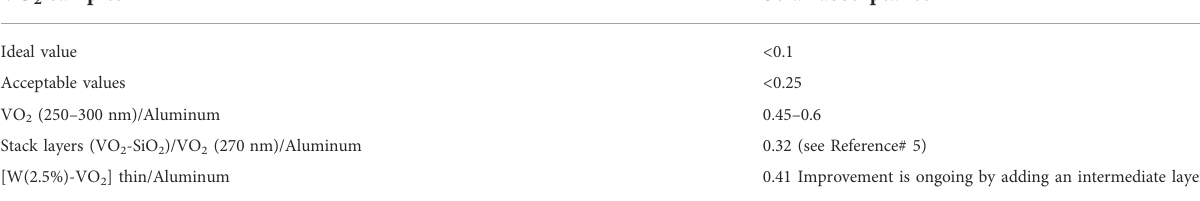
TABLE 2 Comparison of Solar absorptance tests. VO 2